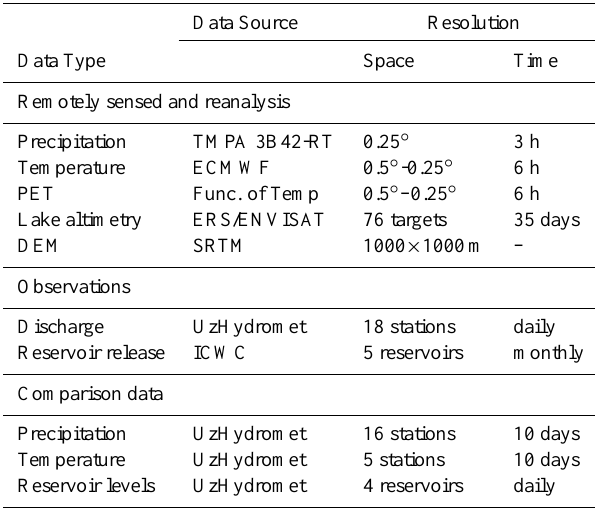
Table 3. Source and spatio-temporal resolution of the various datasets used in the